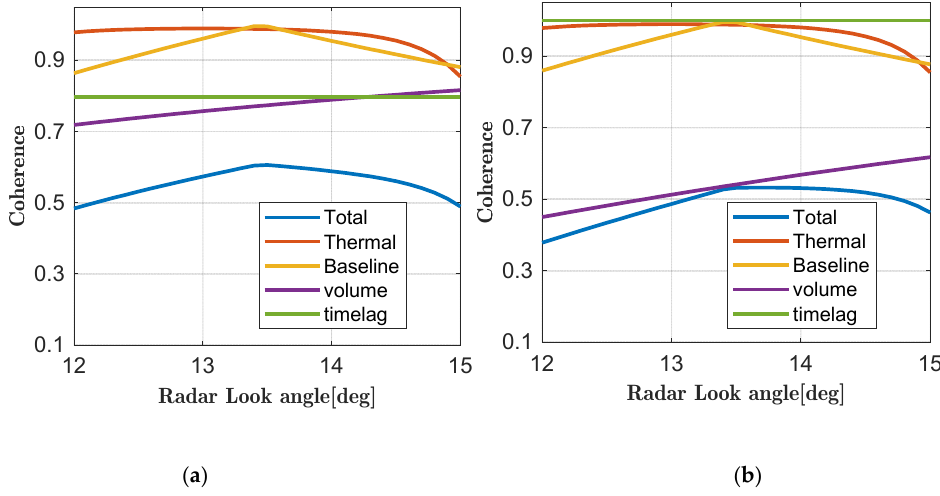
Figure 15. Total coherence alongside other major decorrelation factors of LB-IRA. ( a ) Cross-track baseline length of 629 m, and ( b ) cross-track baseline length of 1000 m.